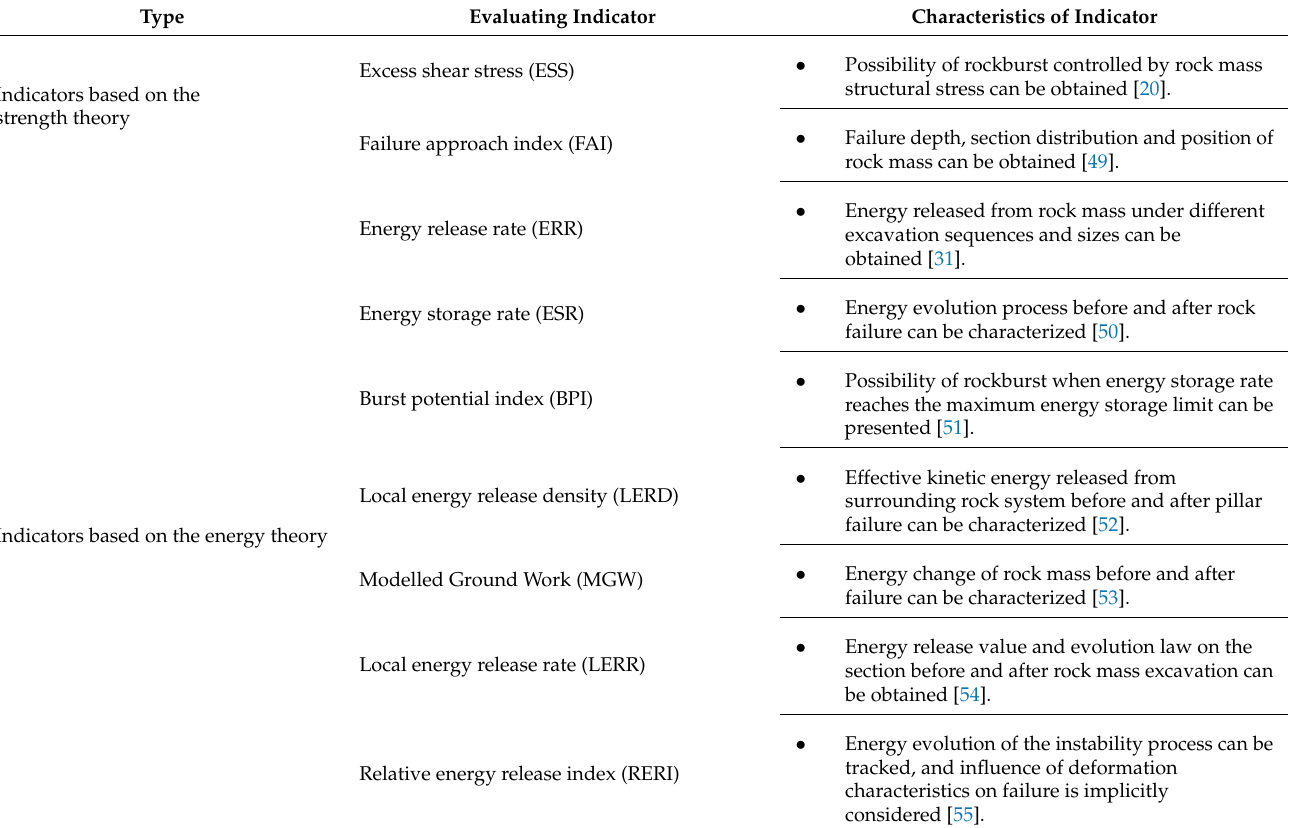
Table 3. Common numerical calculation